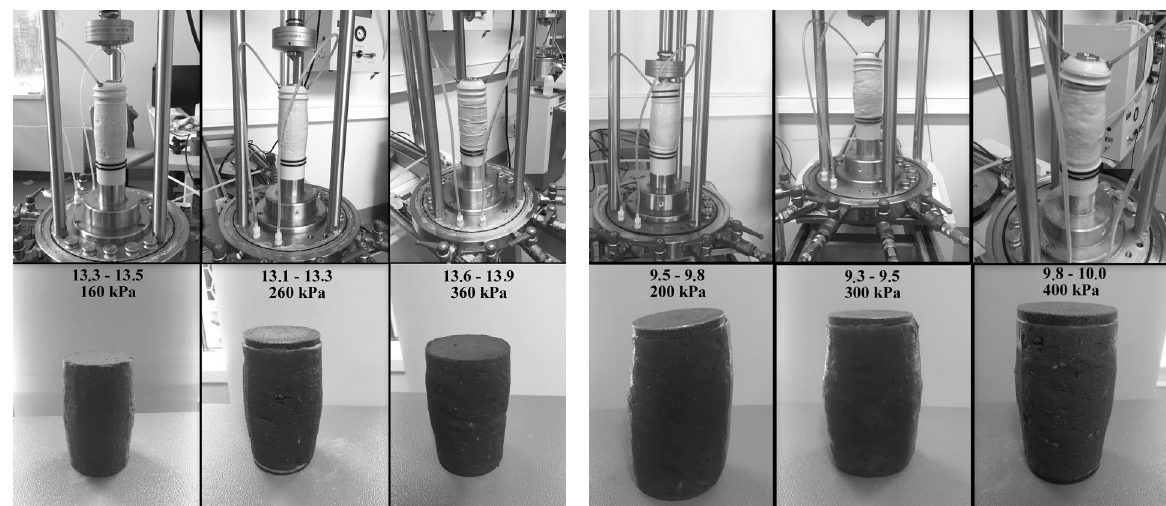
Fig. 6. Right, samples after SCD tests; left, samples after UCU